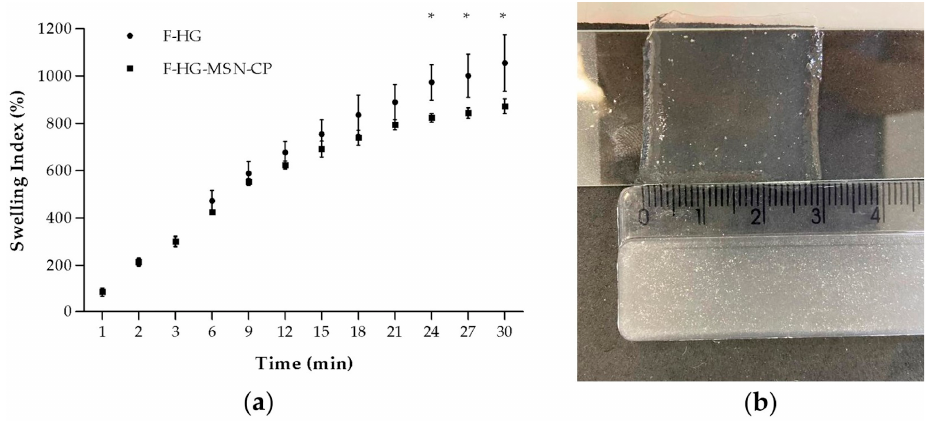
Figure 9. Swelling index profiles of 3D-printed films ( a ): F-HG and F-HG-MSN-CP ( n = 3, mean ± SD). Appearance of the F-HG-MSN-CP after 30 min ( b ). Two-way ANOVA and Bonferroni post hoc test. * p ≤ 0.05.